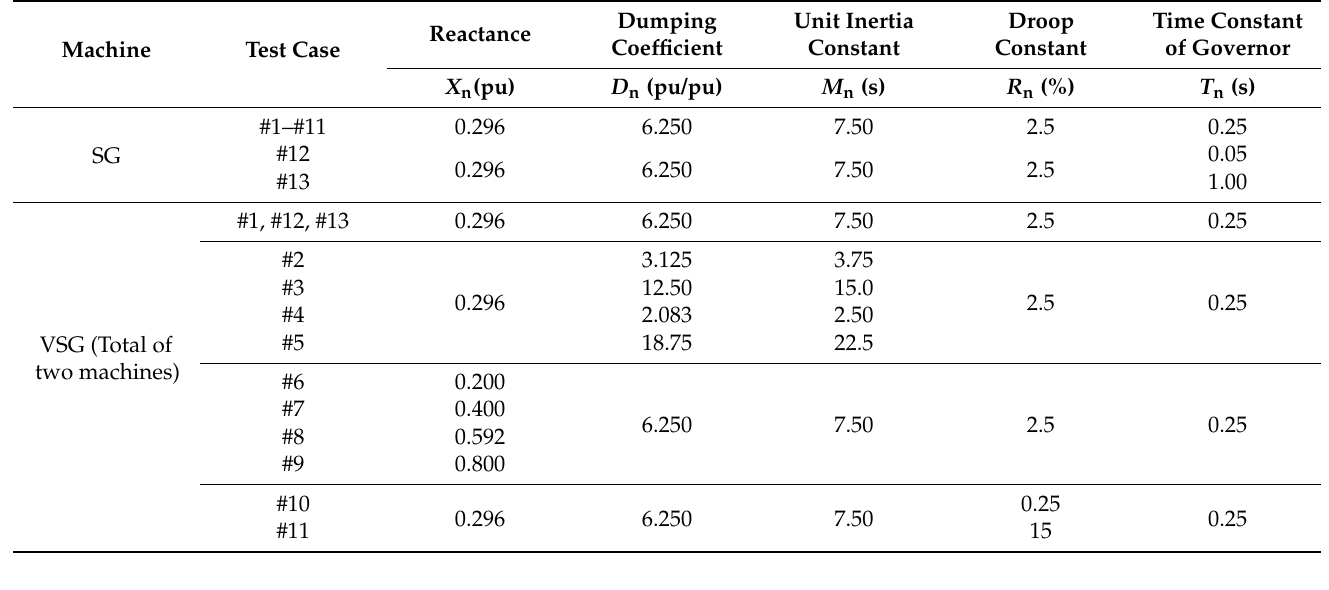
Table 1. Machine constants and control variables.